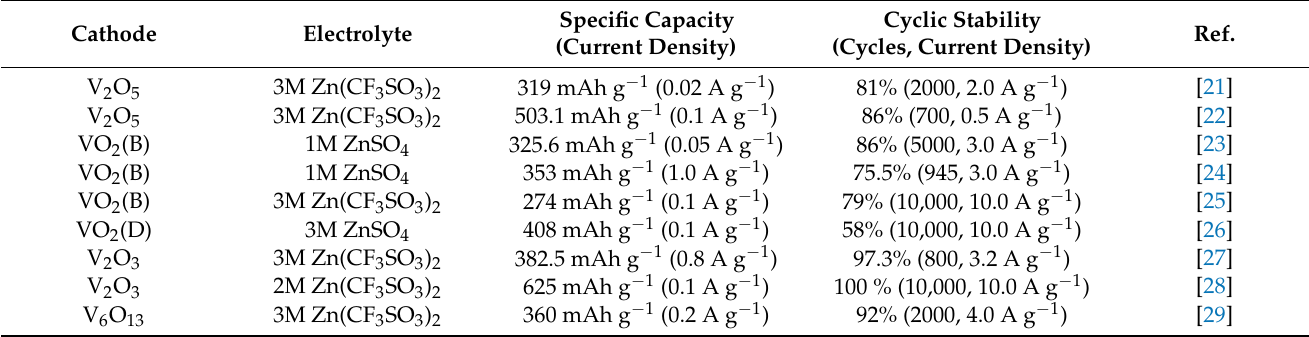
Table 1. Performance comparison of vanadium oxide-based cathode materials. Specific Capacity Cyclic Stability Cathode Electrolyte (Current Density) (Cycles, Current Density)